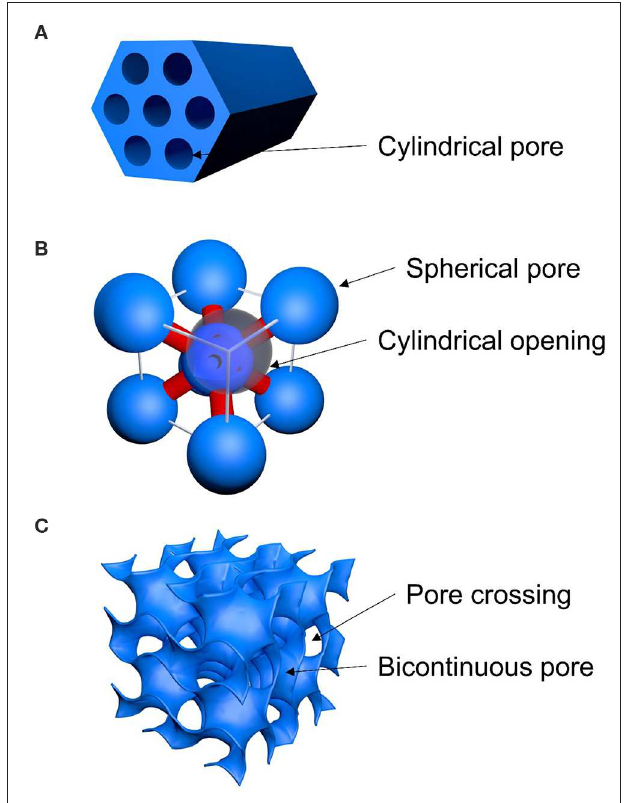
FIGURE 3 | Schematic pore structure of mesoporous silica (A) SBA-15, (B) SBA-16, and (C) FDU-5.